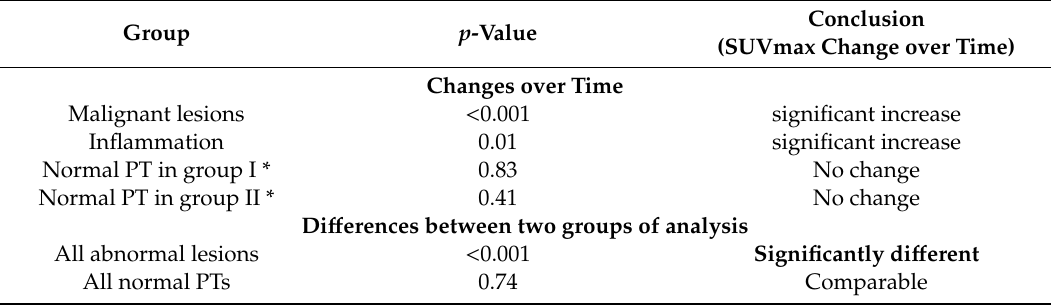
Table 4. The SUVmax changes over